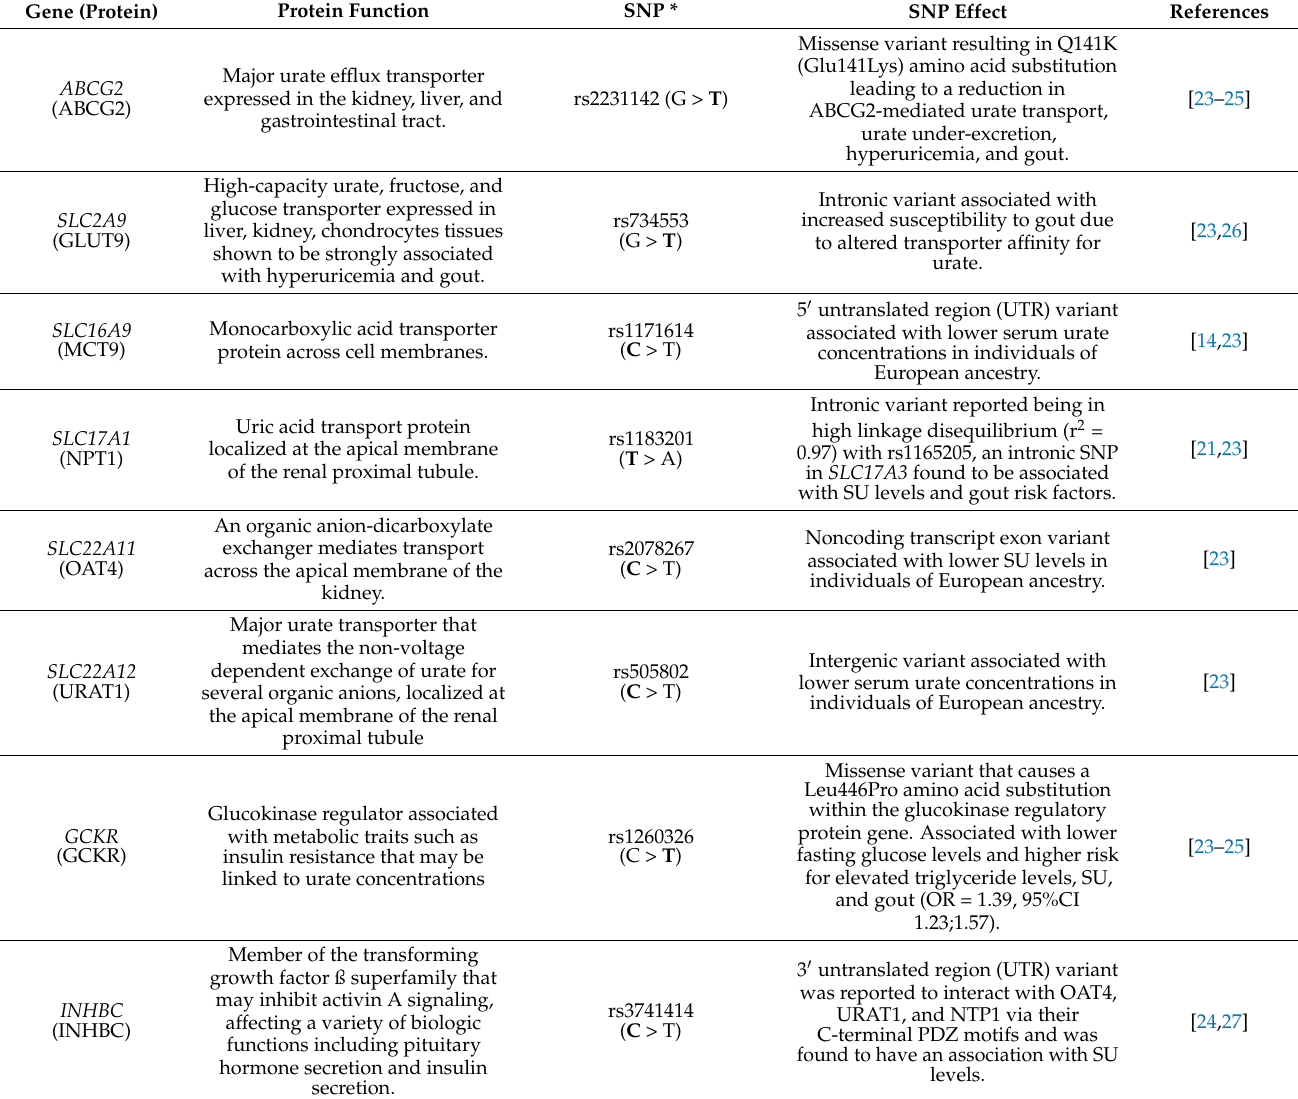
Table 1. Overview of targeted single nucleotide polymorphisms